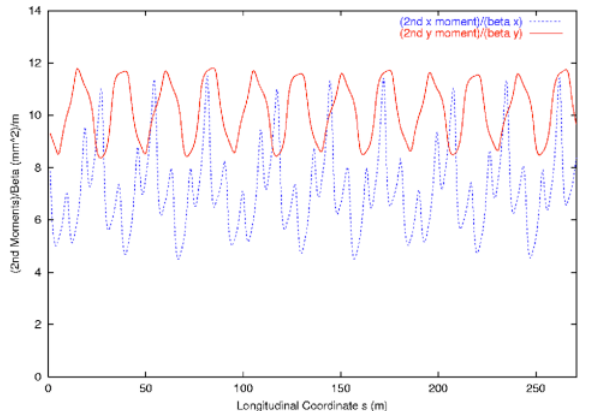
FIG. 3. (Color) Vertical and horizontal beam quadrupole mo- ments versus longitudinal position over the final three turns, for the high intensity case with space charge and no vertical